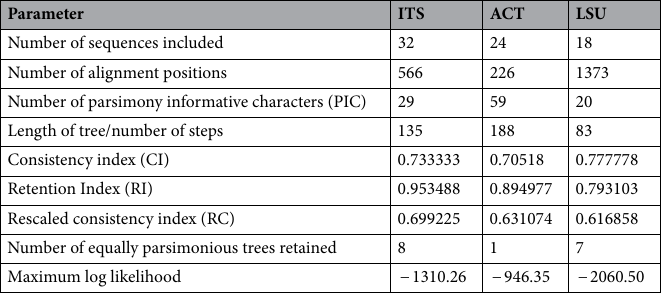
Table 1. Statistical parameters representing phylogenetic studies performed on three distinct loci’s sequence